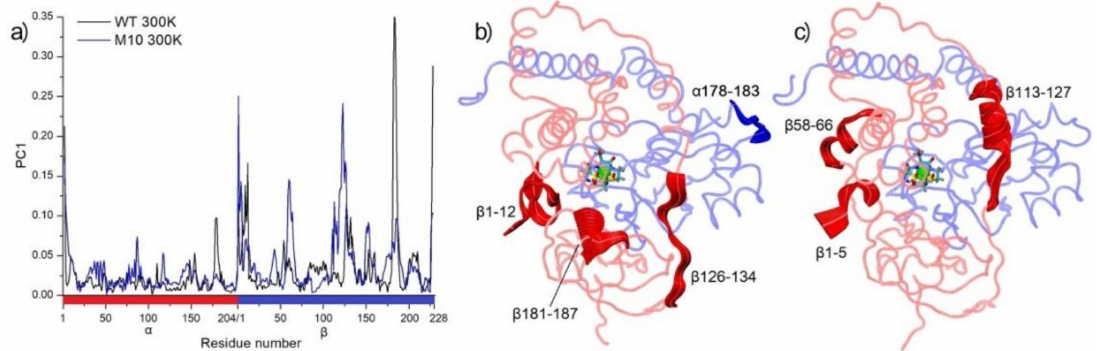
Figure 7. The first principal component (PC1) analysis of molecular dynamics (MD) simulations in 300 K. ( a ) Residue-wise loadings for PC1. Panels ( b ) and ( c ), movements of amino acids with loadings to PC1 bigger than 0.1 for WT and M10,